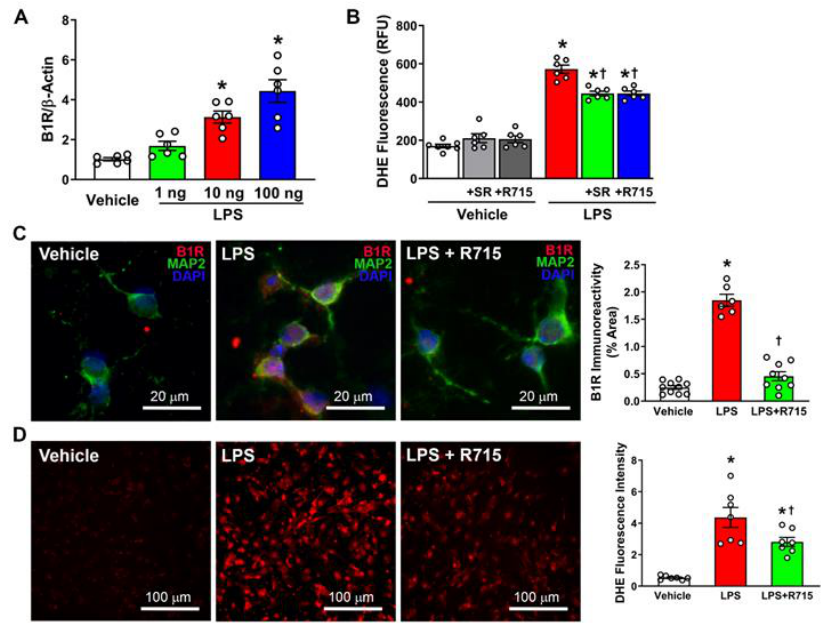
Figure 3. LPS treatment on primary hypothalamic neurons. ( A ) Levels of B1R mRNA measured by real time PCR (n = 6 independent cultures/group). ( B ) ROS production demonstrated using micro- plate DHE assay (n = 6/group). ( C ) Representative images of B1R expression and quantification (n = 6 – 10/group). ( D ) Superoxide production and quantification of DHE immunostaining (n =